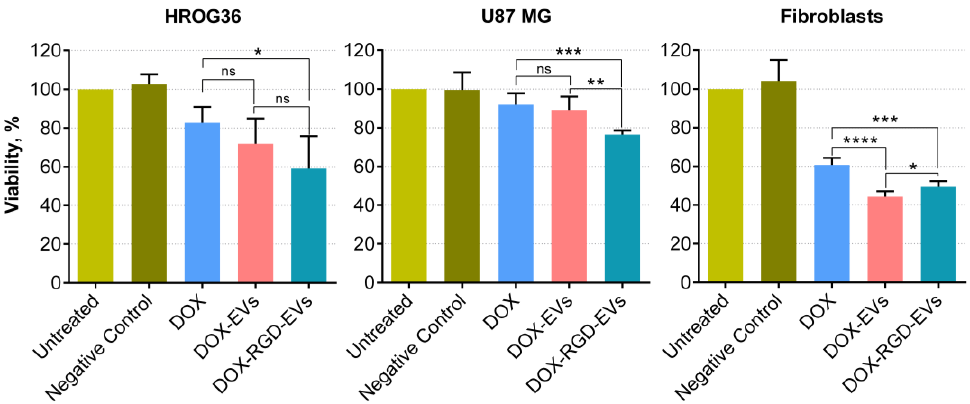
Figure 4. The effect of DOX-loaded EVs on GBM cell and fibroblast viability. Treatment with RGD- EV-encapsulated DOX caused a significant loss in GBM cell viability compared to treatment with free DOX and DOX loaded in RGD-EVs. Such differences between effects on cell viability were not observed in fibroblasts; in contrast, EV-encapsulated DOX decreased fibroblast viability to a significantly greater extent compared to free DOX. Negative Control means treatment with a sample that initially contained the DOX solution without EVs and underwent the same electroporation and cleaning steps as the EVs used for DOX loading. n = 5; * p > 0.05; ** p > 0.01; *** p < 0.001; **** p < 0.001.